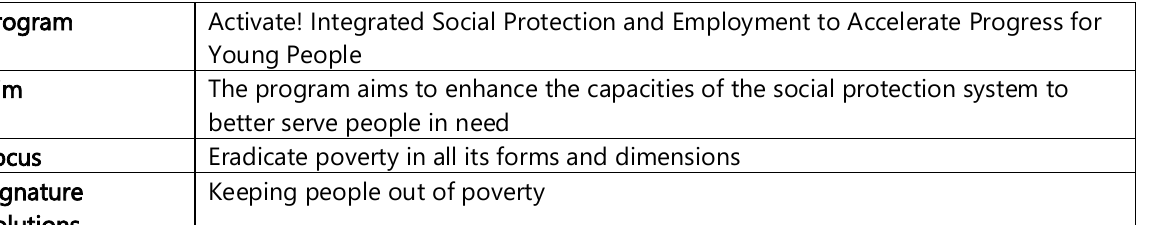
Table 1: The Joint UN Programme „Activate!‟ (Source: UNCT 2021)